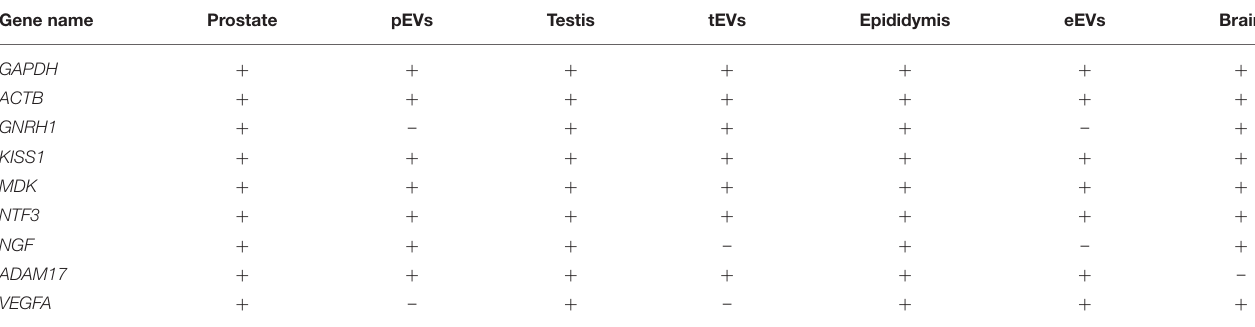
TABLE 2 | Expression of the mRNA transcripts in different parts of male cells and their derived extracellular vesicles (EVs).